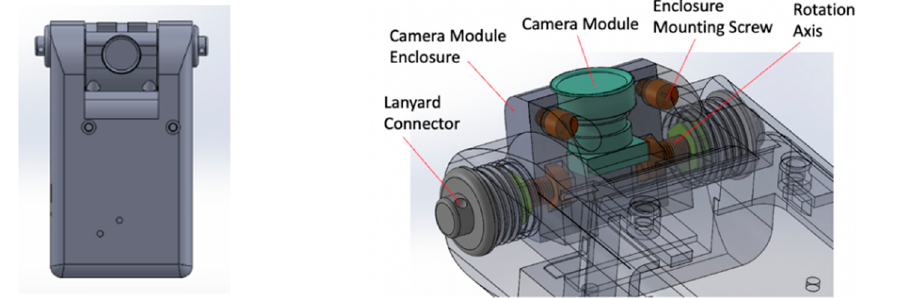
Figure 9. Left panel: Front view of the eButton with adjustable lens orientation; Right panel: Mechanical structure of the lens orientation adjustment assembly. For clarity, the device case is depicted in the transparent form.